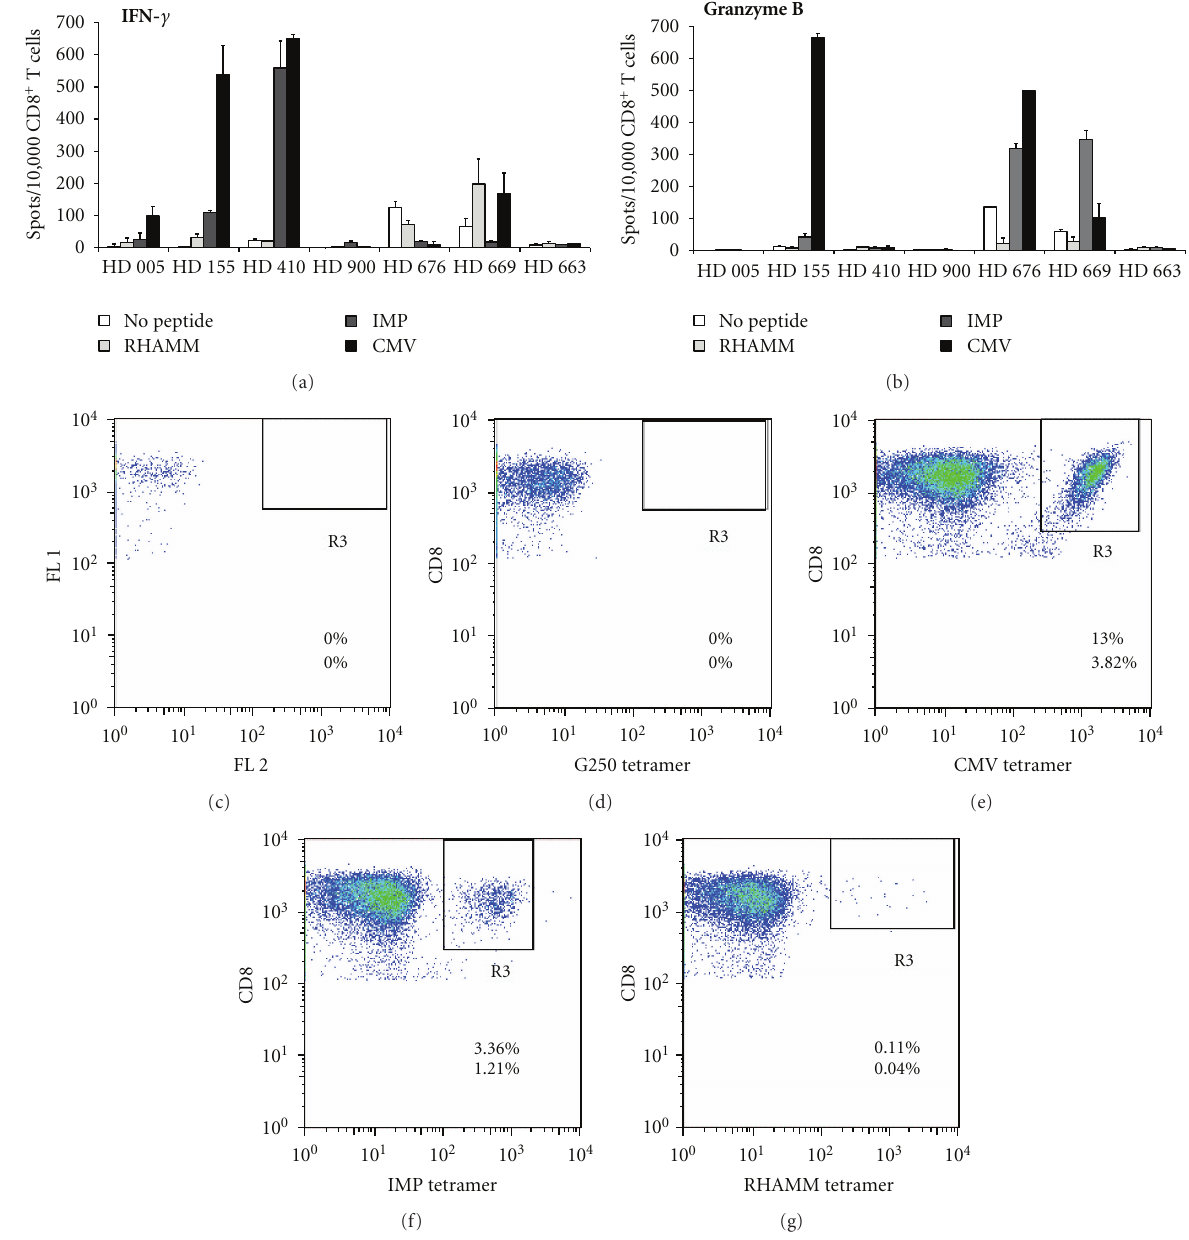
Figure 2: RHAMM-specific CD8 + T-cell frequencies in healthy donors. Cells were stimulated in an MLPC for 7 days with di ff erent peptides and tested for their reactivity in ELISPOT assays for IFN- γ (a) and granzyme B (b) release. Stimulation of cells without any peptide was used as negative control (no peptide), whereas T cells stimulated with CMV and IMP peptides served as positive controls. RHAMM-specific T cells could be detected in two healthy donors (HD 155 and HD 669) by IFN- γ ELISPOT, (c)–(g) RHAMM-specific T-cell frequencies were determined by flow cytometry in HD 155. Reported frequencies correspond to gated CD3 + CD8 + T cells (upper numbers), and from all cells in the lymphocyte gate (lower numbers). (c) Fluorescence minus one (FMO) was used as negative control to assess the intrinsic fluorescence of the cells. (d) As a further negative control, cells were cultured in the absence of any peptide and stained with tetramers specific for the irrelevant antigen G250. As positive controls, CD8 + T cells were stimulated with either (e) CMVpp65 peptide or (f) IMP-derived peptide, (g) CD8 + T cells were stimulated with RHAMM peptide, (e)–(g) CD8 + T cells were stained with respective